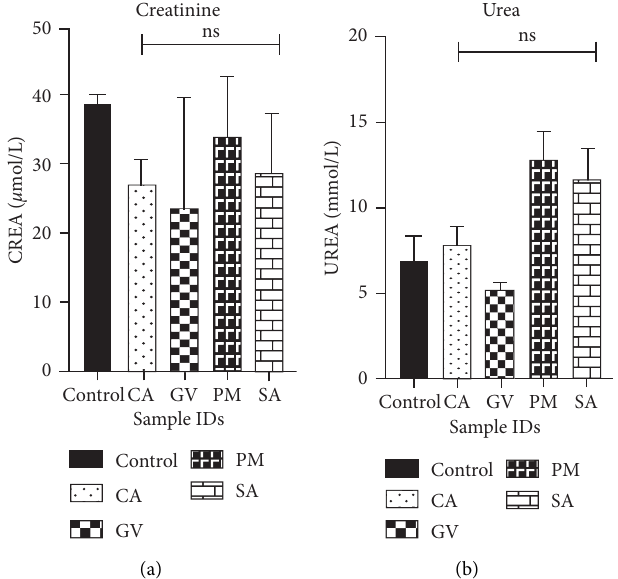
Figure 3: Effect of selected plant extracts on kidney function profile ( n � 3). CA: Celtis africana , GV: Grosseria vignei , PM: Physalis micrantha , SA: Stachytarpheta angustifolia. (a) CREA: creatinine and (b) UREA: urea. Each bar represents mean ± SEM ( n � 3). p < 0 . 05 was considered to be statistically significant (one-way analysis of variance (ANOVA) followed by Dunnett’s post hoc